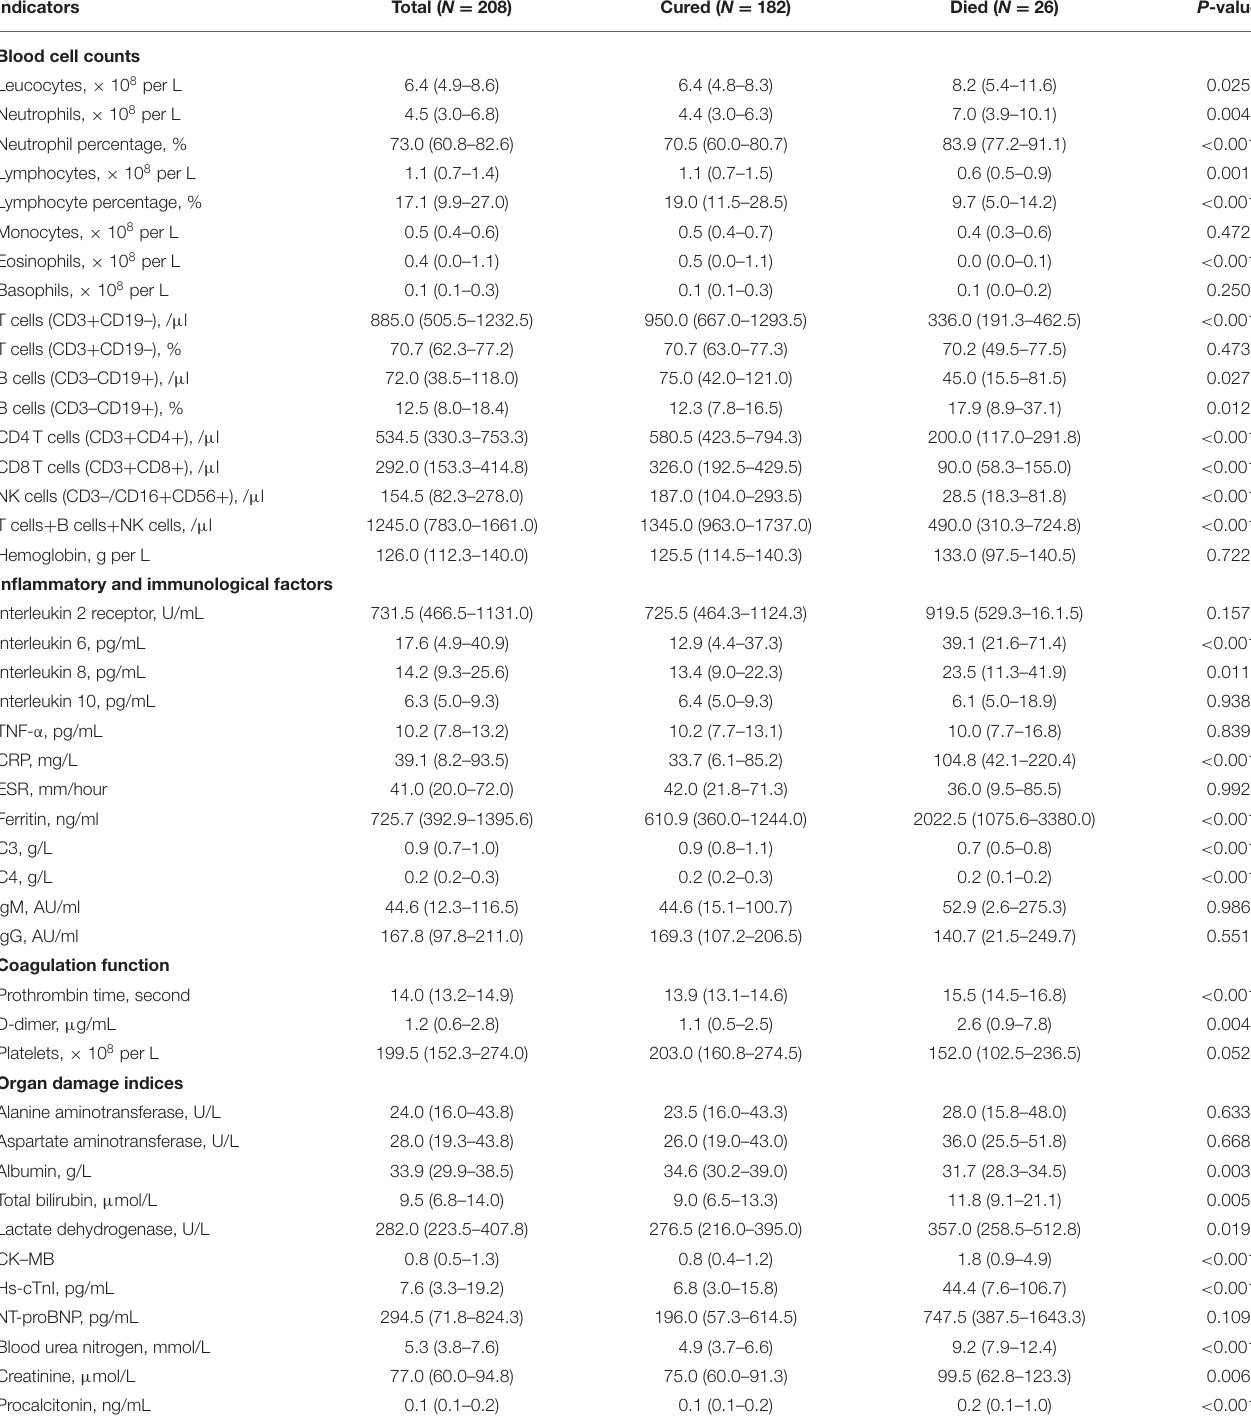
TABLE 2 | Laboratory findings of COVID-19